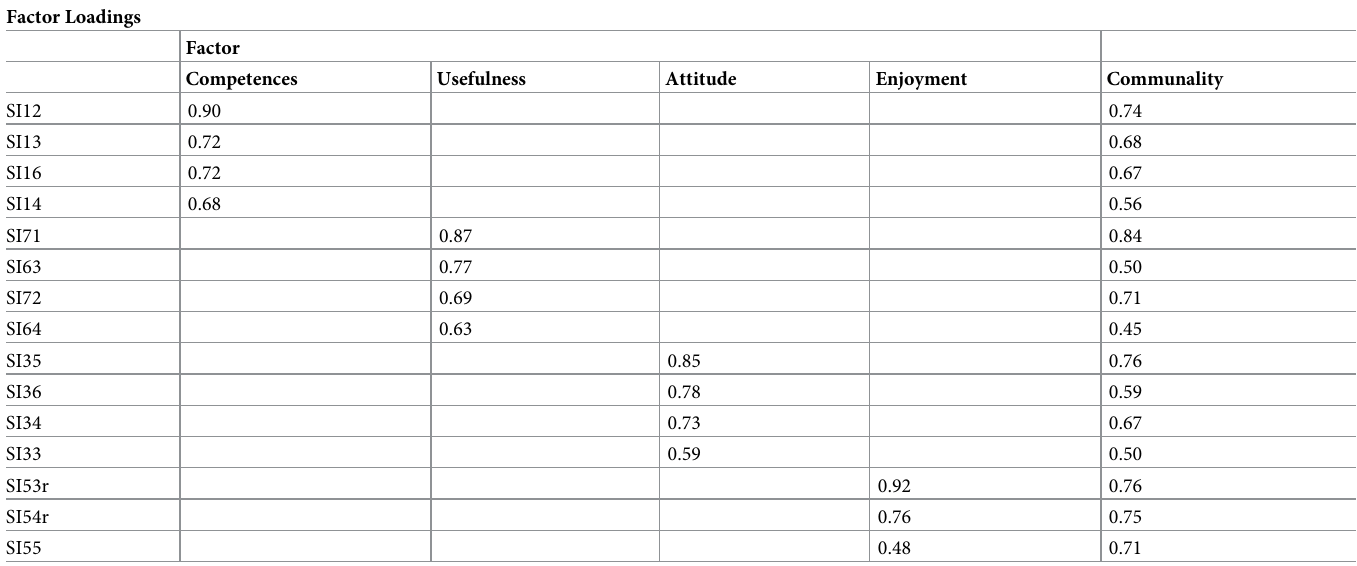
Table 2. Factor loadings from exploratory factor analysis for total sample (N =